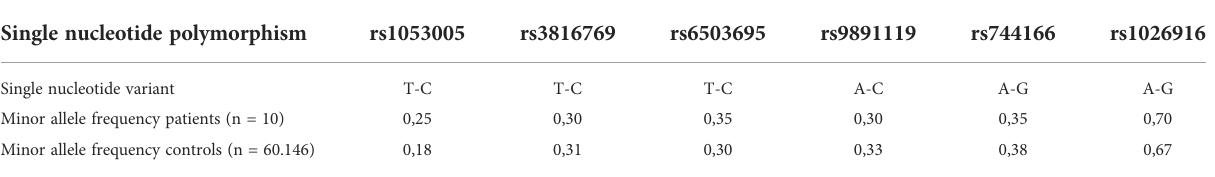
TABLE 3 Allele frequencies of six single nucleotide polymorphisms in STAT3 in ten patients with CSU aiTIIb compared to controls. Single nucleotide polymorphism